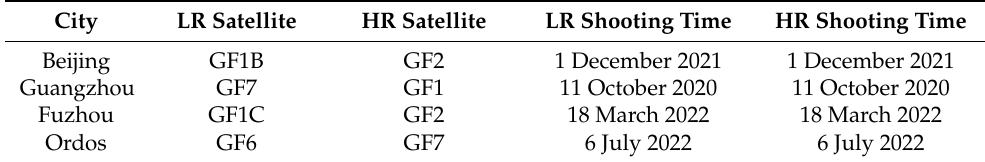
Table 2. The shooting times and satellites in the different regions. In the following table, LR and HR are